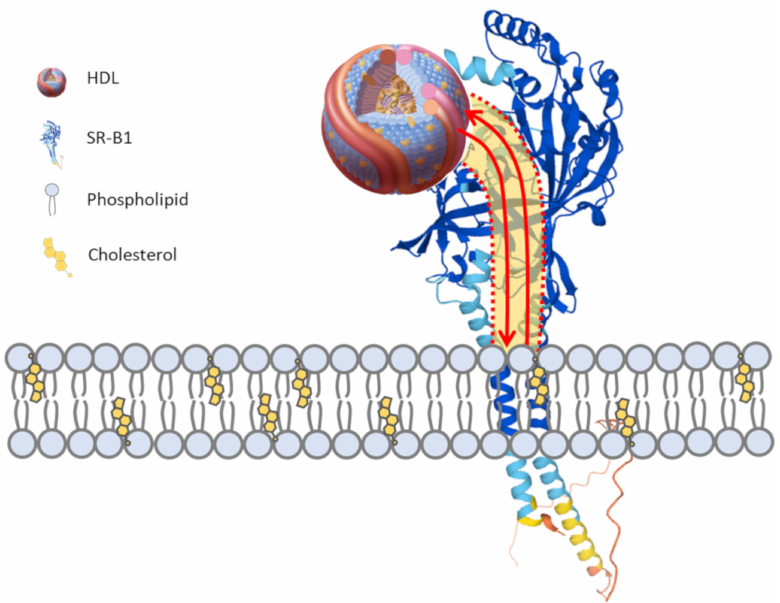
Figure 1. HDL and SR-B1 selective lipid exchange . The high-density lipoprotein (HDL) receptor, scavenger receptor class B type I (SR-B1), contains two transmembrane domains and a large extracel- lular domain that contains a hydrophobic channel (depicted in yellow shading bound by dashed red lines) leading from the HDL binding site to the juxtamembrane region. The binding of HDL to SR-B1 on the surface of cells promotes the bidirectional flow of lipids (red arrows) through the hydrophobic channel of SR-B1 to the membrane. Lipids are exchanged between HDL and the cell without the net internalization or degradation of the HDL particle. The concentration gradient of cholesterol between HDL and the cell plasma membrane is thought to dictate whether there is a net cellular uptake or efflux of lipids. The predicted structure of HDL was from [45]. The predicted structure of human SR-B1 was generated using Alphafold and based on [46]. The SR-B1 structure was first reported by